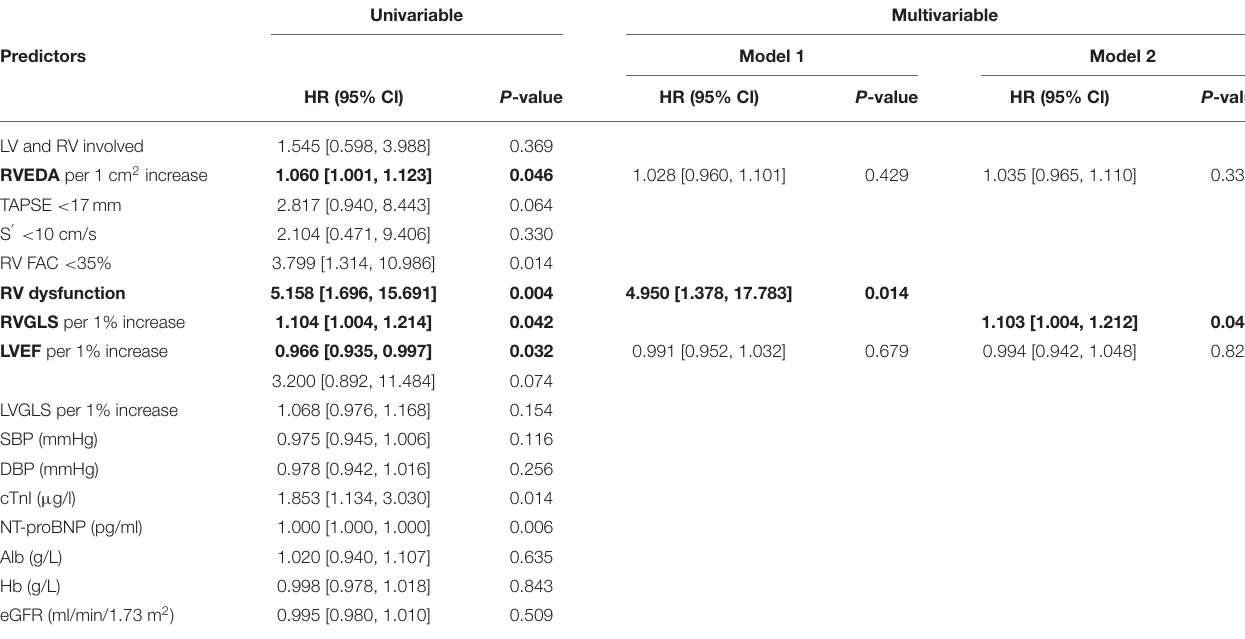
TABLE 4 | Predictors of